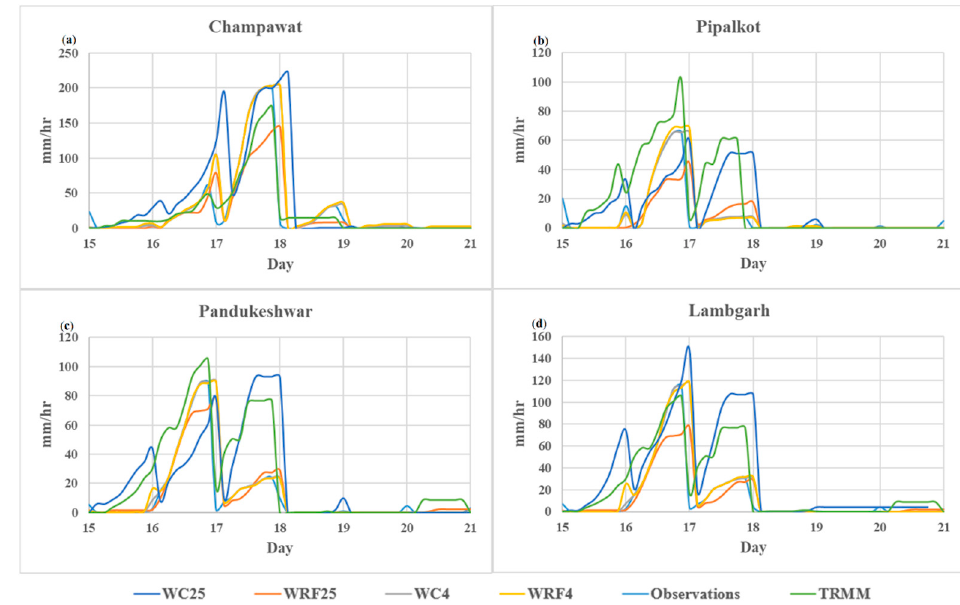
Figure 3. Precipitation from different simulations and observations from 15–20 June 2013 for ( a ) Cham- pawat, ( b ) Pipalkoti, ( c ) Pandukeshwar, and ( d )